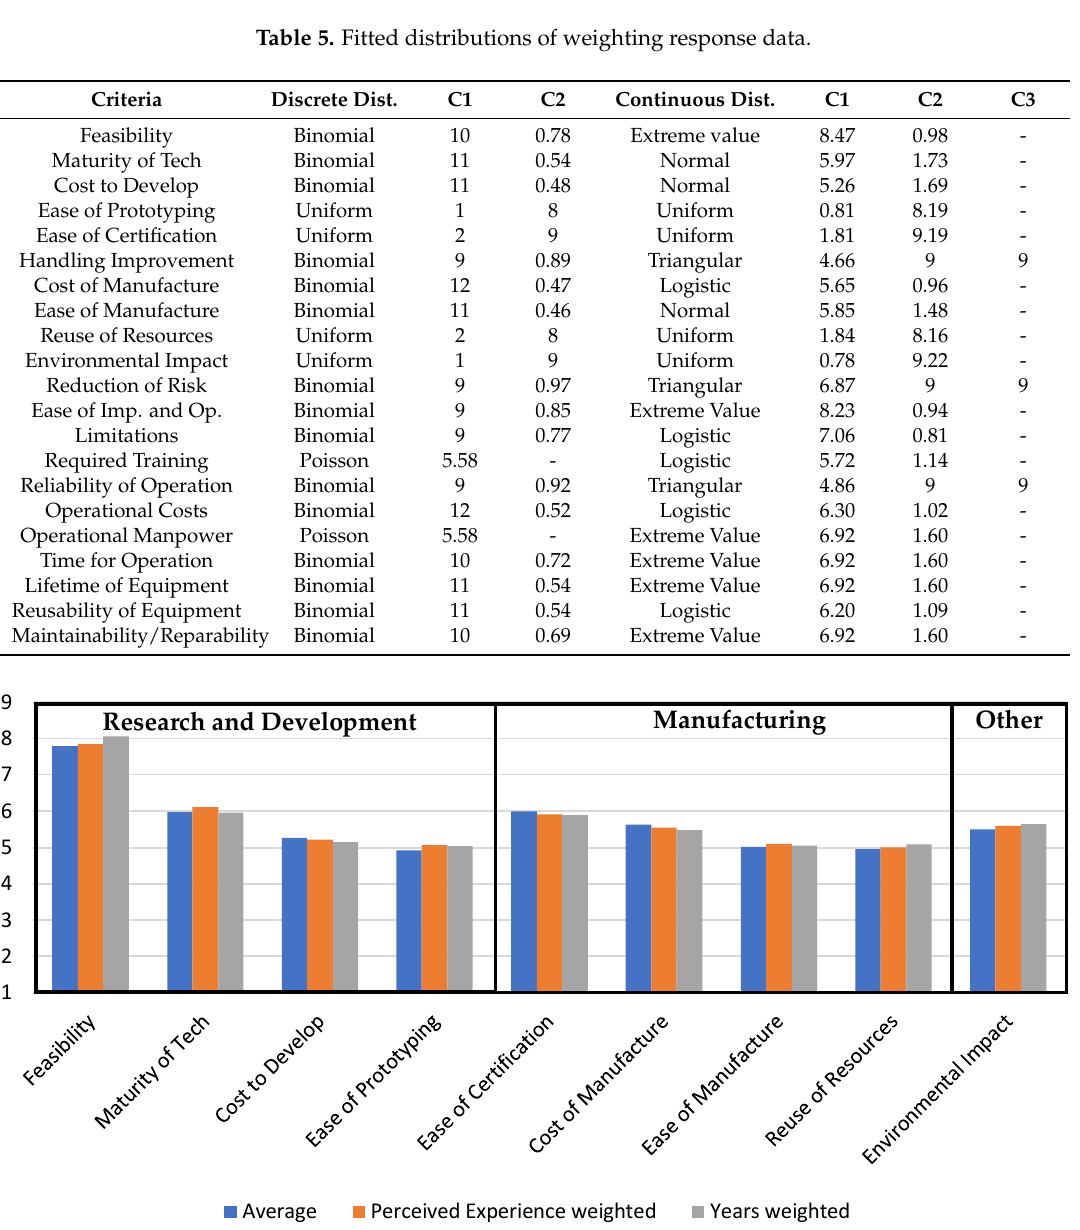
Figure 7. Averaged responses to the sections ‘Research + Development’, ‘Manufacturing’ and ‘Other’.